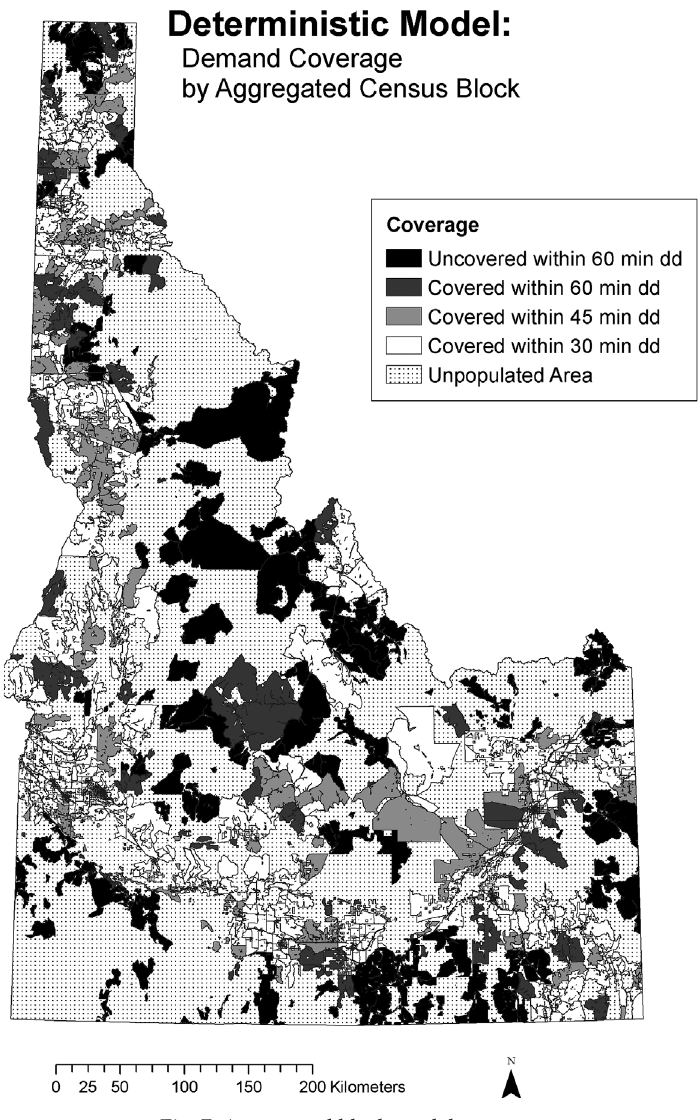
Fig. 7. Aggregated block model